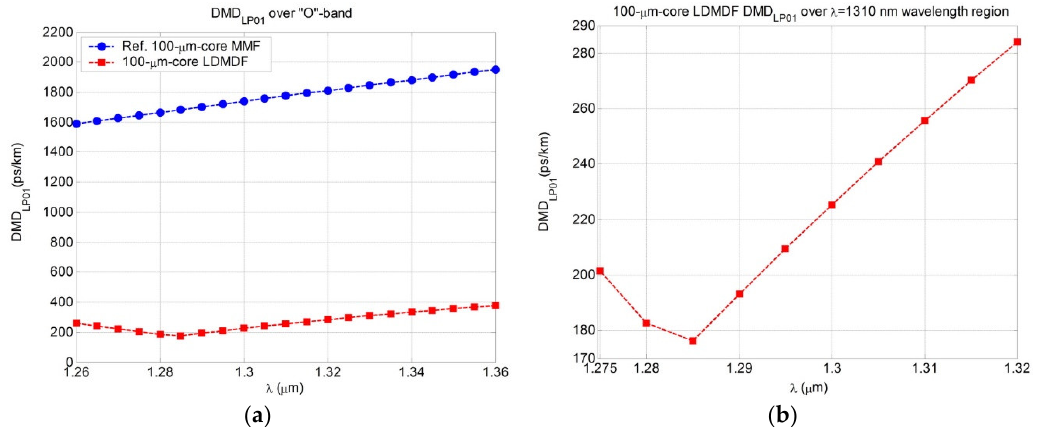
Figure 6. DMD diagrams computed for selection under a centralized launching condition mode staff for the reference MMF and LDMDF.